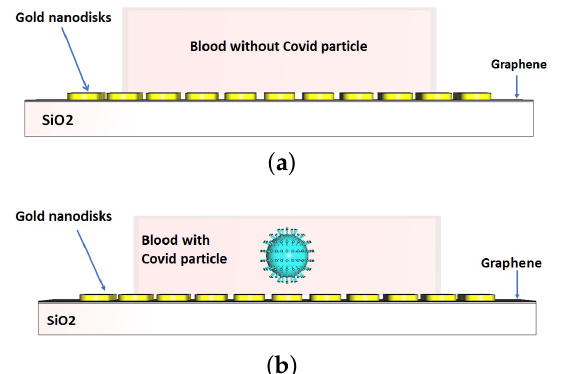
Figure 10. A graphical screen of the nanosensor under test with blood samples in two states: ( a ) without COVID-19 particle and ( b ) with COVID-19 particle. The geometric size of COVID-19 particle model is based on r = 70 nm, h = 20 nm, D = 8 nm, and N =